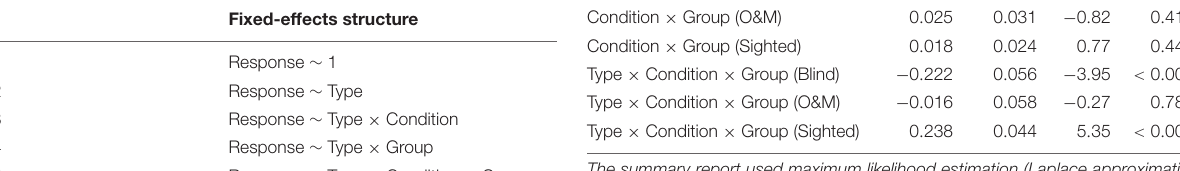
TABLE 2 | Model specifications in R package lme4. Model